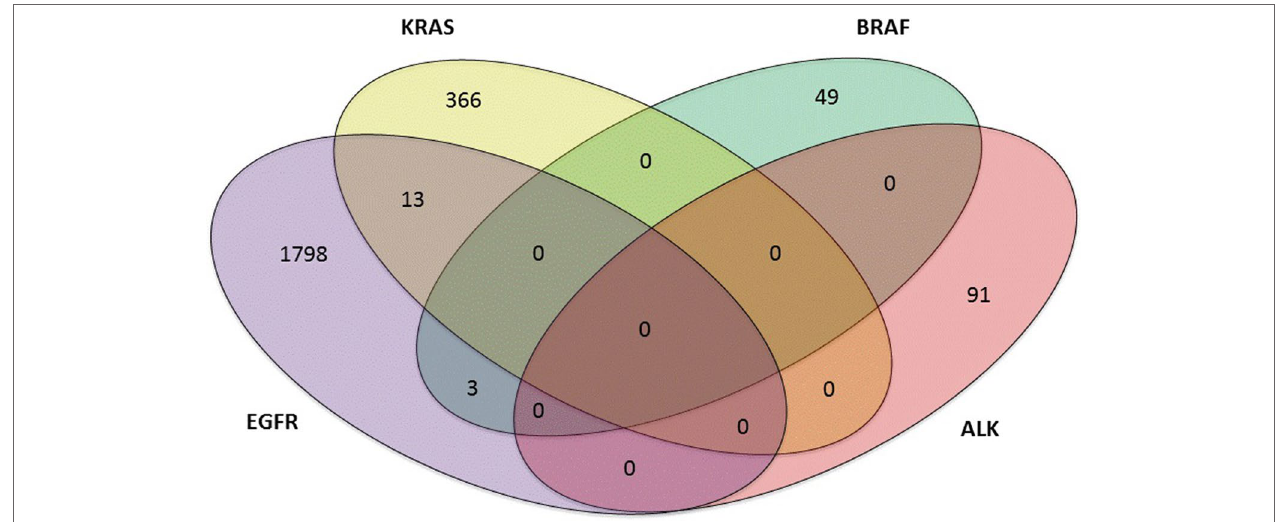
FIGURE 2 | Four-set venn-diagram of single and multiple mutation panoramagram for lung adenocarcinoma tissue samples.